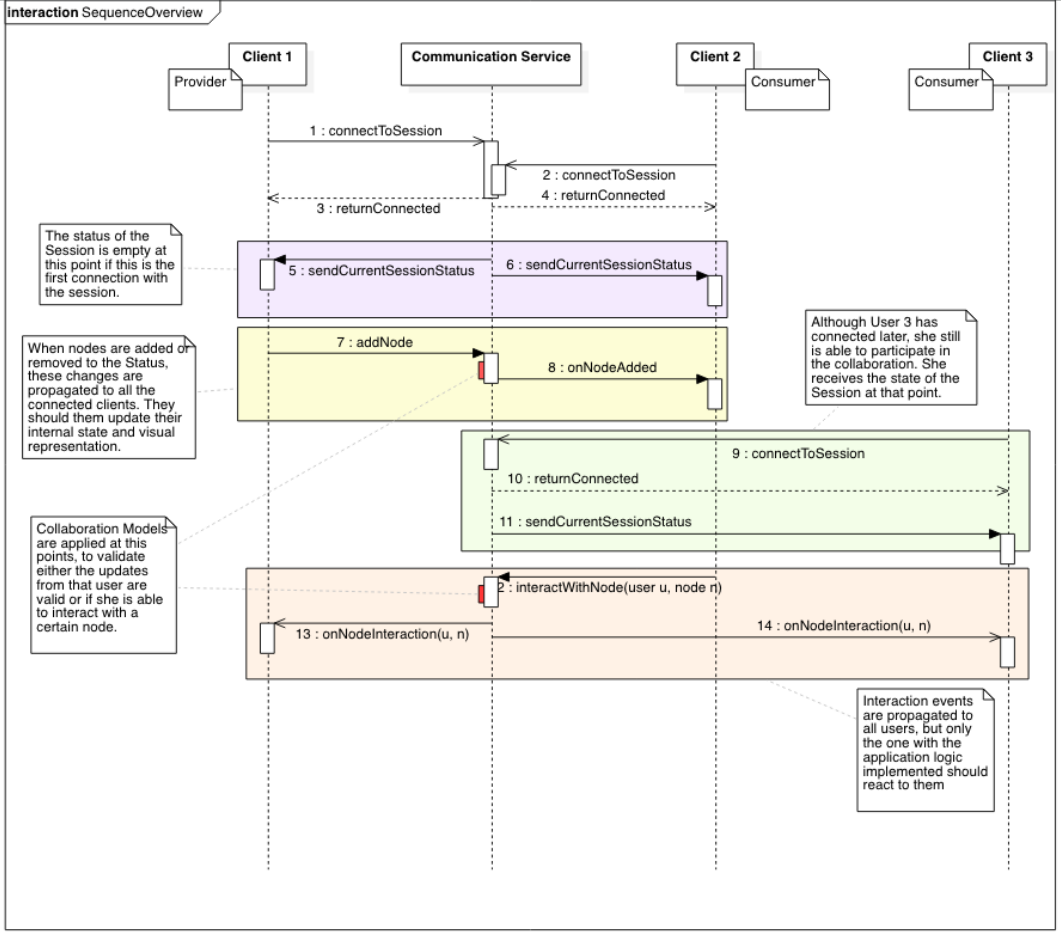
Figure 5. Sequence diagram that illustrates the communication between users and the Communication Service